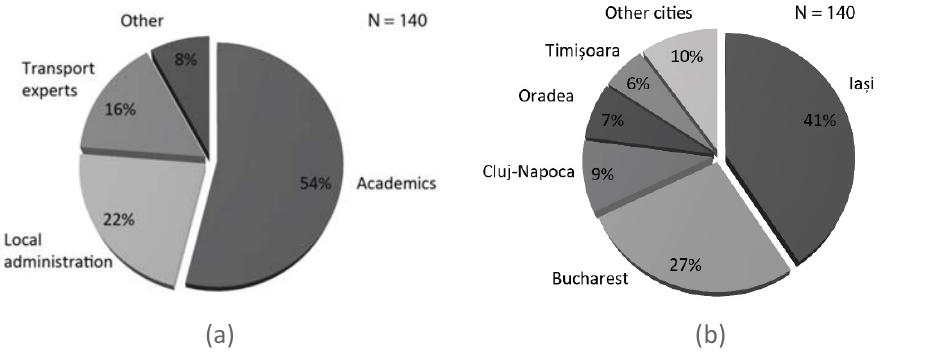
Figure 2: The structure of the sample used for the survey by: ( a ) Field of work; ( b ) city Source: own representation